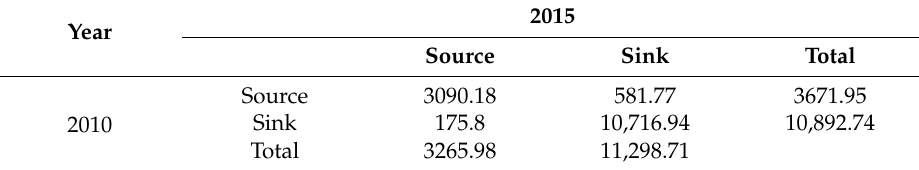
Table 28. The source-sink landscape transition matrix from 2010 to 2015 (km 2